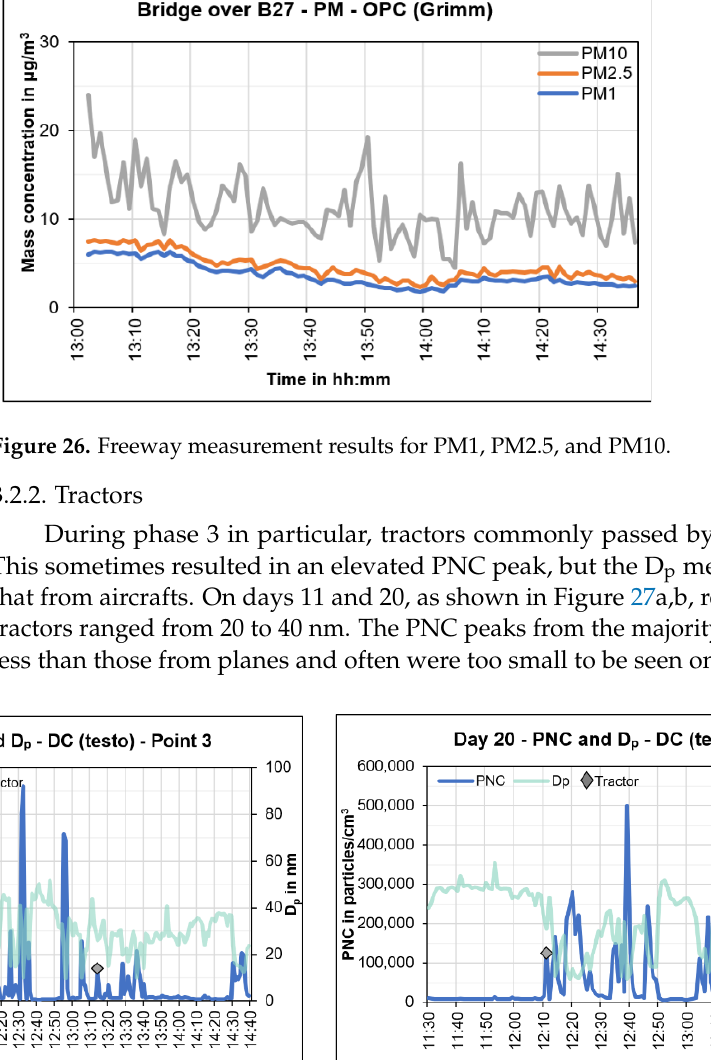
Figure 25. Freeway measurement results for ( a ) UFP PNC and D p from DC DiSCmini (testo) and ( b ) PSD combination.